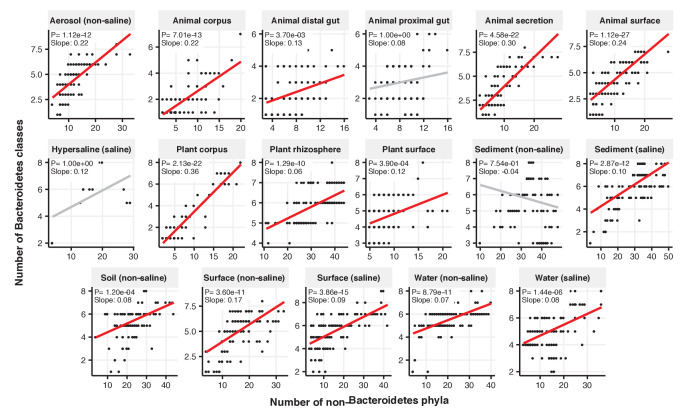
Focal-lineage diversity as a function of community diversity across biomes in Bacteroidetes.Linear models are shown for the number of classes per phylum (y-axis) as a function of community diversity (number of non-focal phyla, x-axis) in each of the 17 environments (EMPO3 biomes). Only environments containing the focal lineage are shown. P-values are Bonferroni corrected for 17 tests. Significant (p<0.05) models are shown with red trend lines.